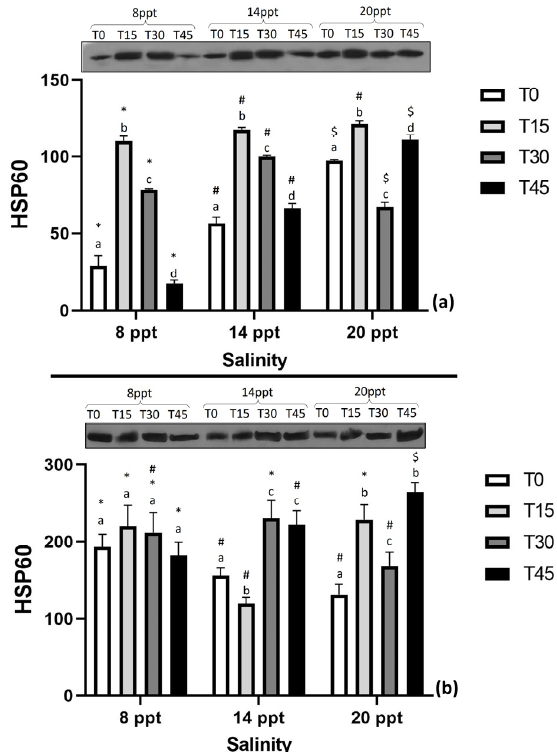
Figure 2. Induction of Hsp60 in the liver ( a ) and gills ( b ) of gilthead sea bream following exposure to a salinity of 8, 14, or 20 ppt for 0, 15, 30, and 45 days. Different bar colors represent the exposure time to the experimental salinities (T0: 0 days, T15: 15 days, T30: 30 days, and T45: 45 days). Data are expressed as mean values of three replicates ± S.D. Different letters depict significant changes in Hsp60 expression between different exposure times in each salinity, while different symbols (*, #, and $) are used to denote significant differences between the three experimental salinities at the same exposure time.